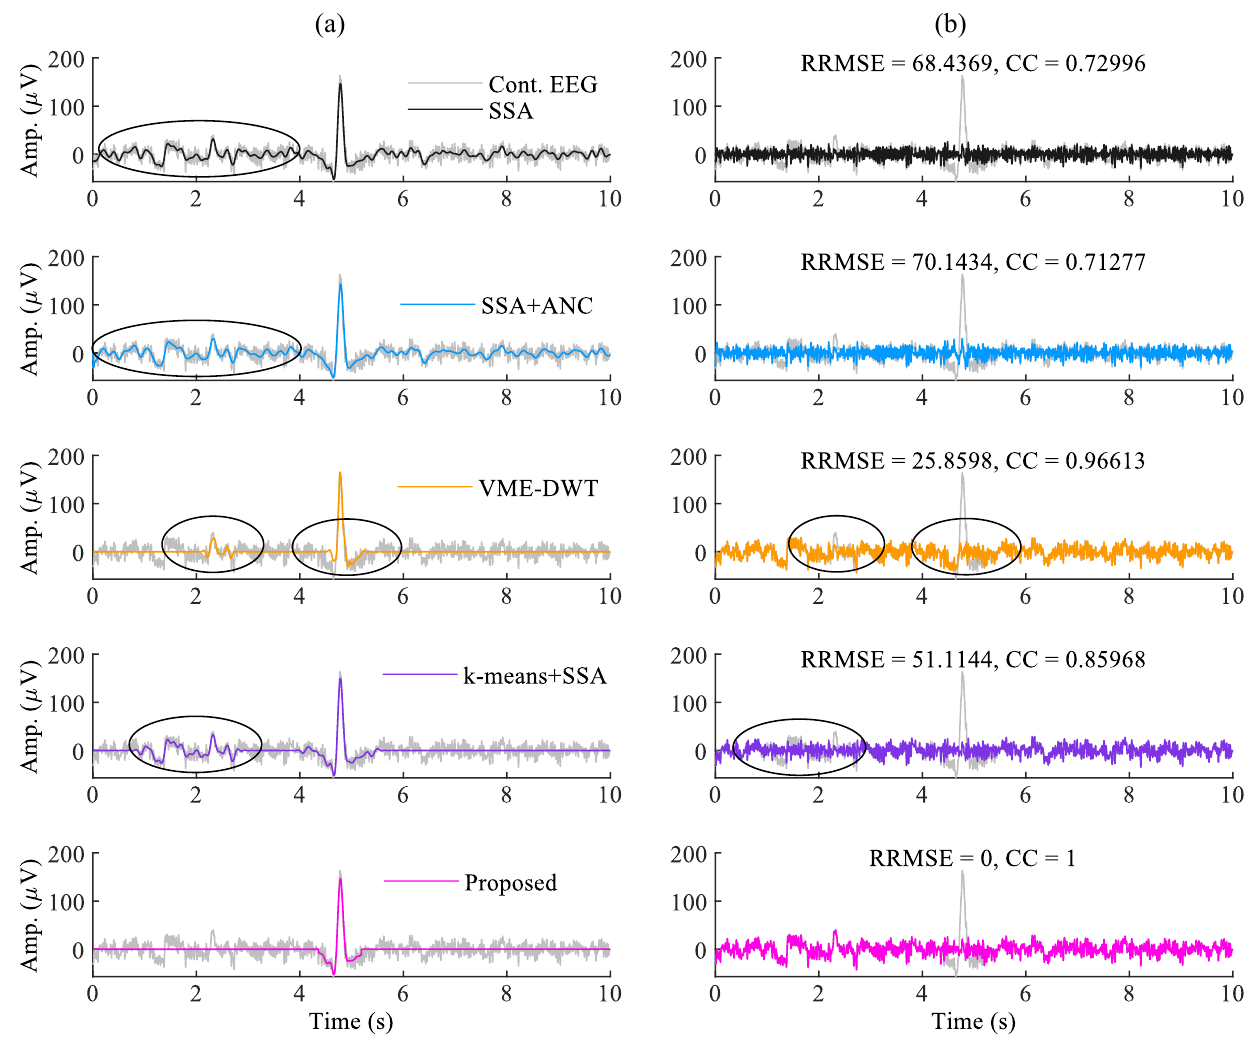
Figure 7. ( a ) The estimated eye-blink artifact (ˆ a ) and ( b ) the corrected EEG signals (ˆ s ) from the contaminated EEG signal ( y ) using the existing and the proposed